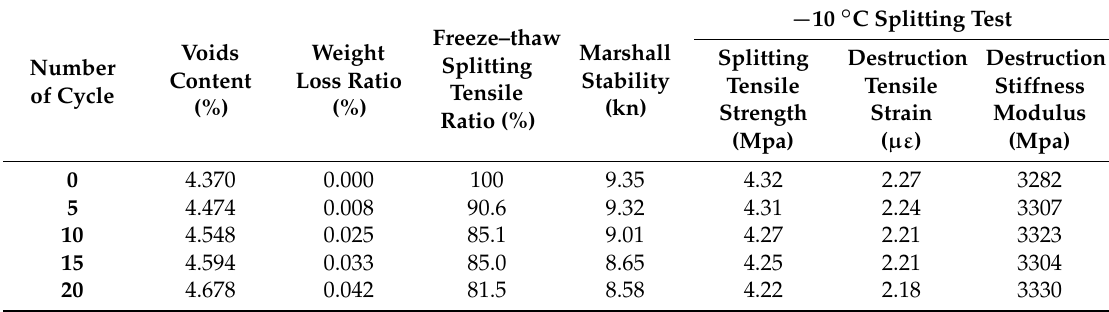
Table 9. Variation of NHSS-AC parameters under scouring